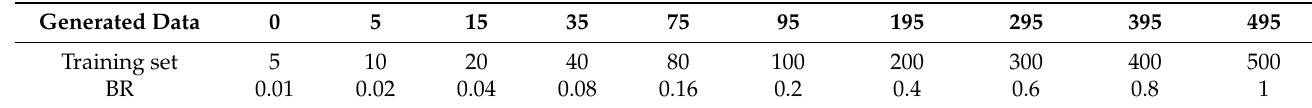
Table 7. Range of variation of BR.